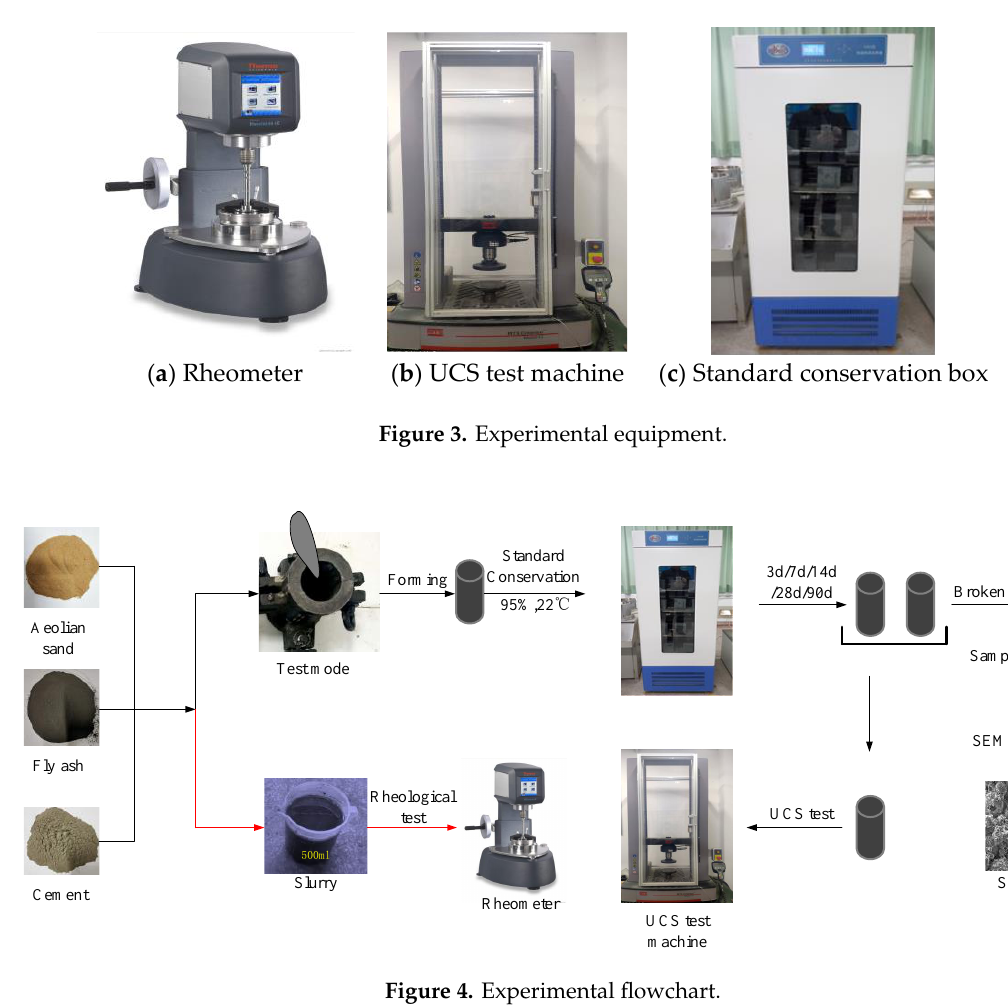
Figure 3. Experimental equipment.